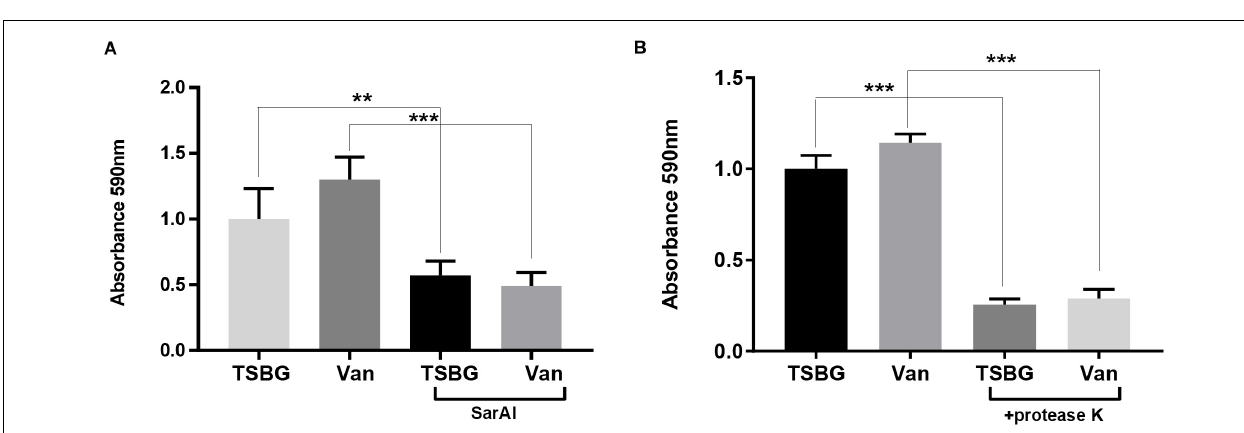
( Figure 5A ) ( p < 0.01/ p < 0.001 for groups with/without vancomycin,